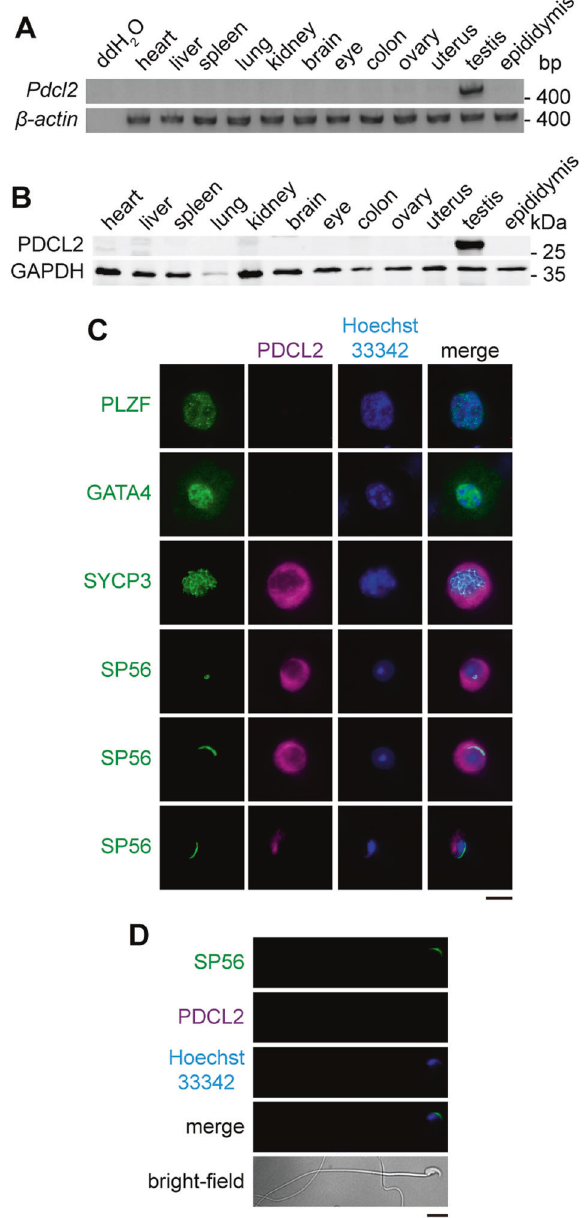
Fig. 1 Pdcl2 is predominantly expressed in testis with a stage- speci fi c pattern. A , B Expression analysis in various tissues from wild-type 11-week-old C57BL/6 mice. A RT-PCR results. The ddH 2 O group was used as PCR control. The β -actin group was used as loading control. B Western blot analysis. GAPDH was used as loading control. C , D Immuno fl uorescence staining of different germ cells extracted from testes and mature sperm isolated from cauda epididymis of wild-type 11-week-old C57BL/6 mice. Green indicates different markers of the cells. PLZF is a marker of spermatogonial stem cell. SYCP3 is a synaptonemal complex component. SP56 is a constituent of the acrosomal matrix. PDCL2 was labeled in magenta. Hoechst 33342 labeled cell nuclear was in blue. Bar, 10